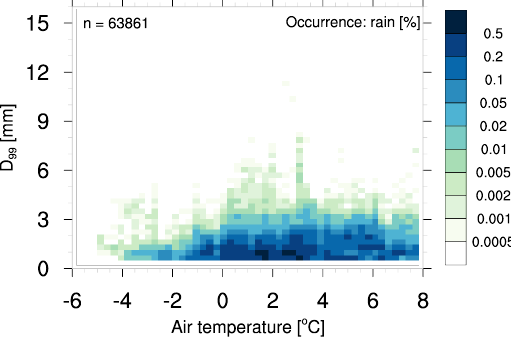
Figure 7. Two-dimensional histogram of temperature and the 99th percentile of the particle diameter for cases classified as rain by the manual PP estimation in